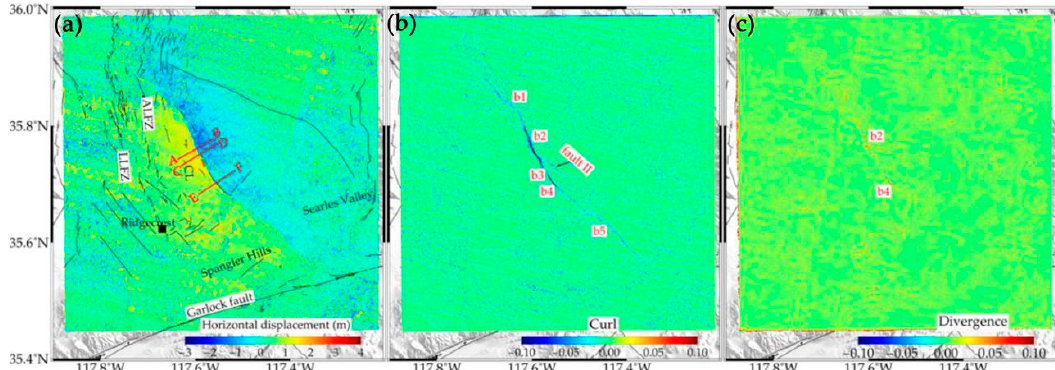
Figure 6. Curl and divergence of the surface ruptures due to the mainshock. ( a ) Coseismic horizontal displacement field derived from the NS and EW displacement components. Amplitude of displacement is negative for southward motion. ( b ) Curl ω and ( c ) divergence δ derived from the NS and EW displacement components. Across-fault profiles (AB, CD, and EF) reveal detailed characteristics of the surface rupture zone (both near-field and far-field). Geometrical complexities of the surface rupture contributed by the Mw7.1 event are indicated in bend b1-b5.